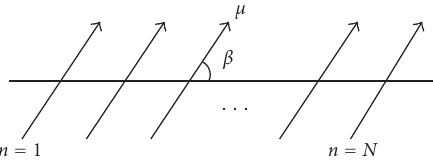
Figure 1: Linear aggregate of N equidistant molecules with parallel transition dipoles of magnitude μ . For β < 54 . 7 ◦ , the intermolecular dipole-dipole interaction is negative and the chain is a J-aggregate; otherwise it is an